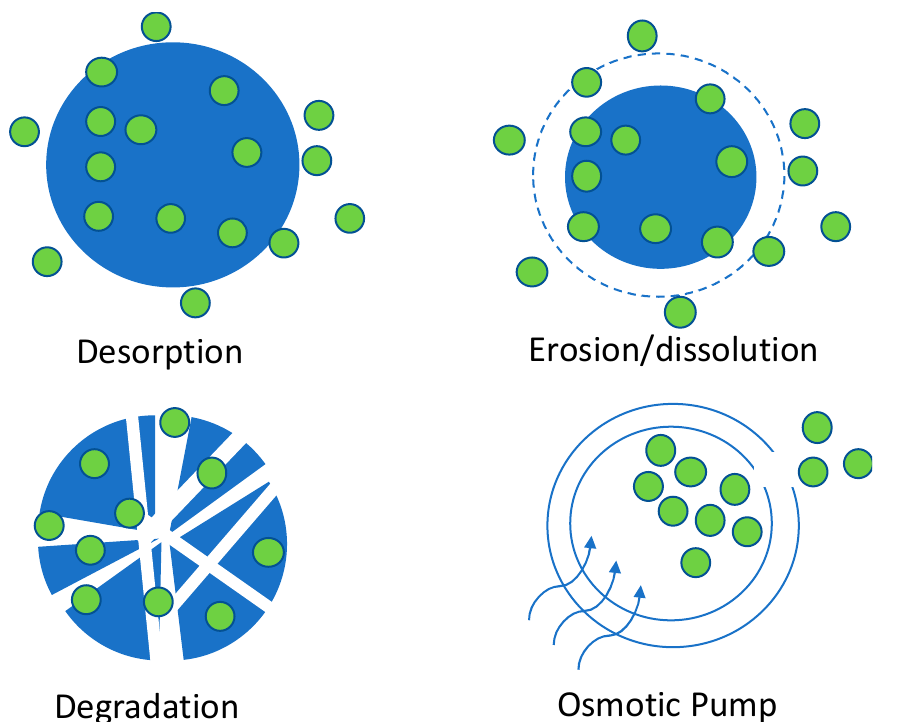
Figure 6. Drug-releasing mechanism of chemotherapeutic drugs.